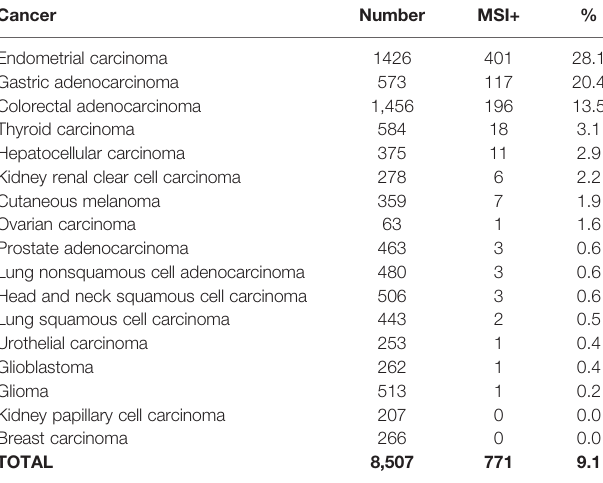
TABLE 1 | MSI+ frequency in different tumor